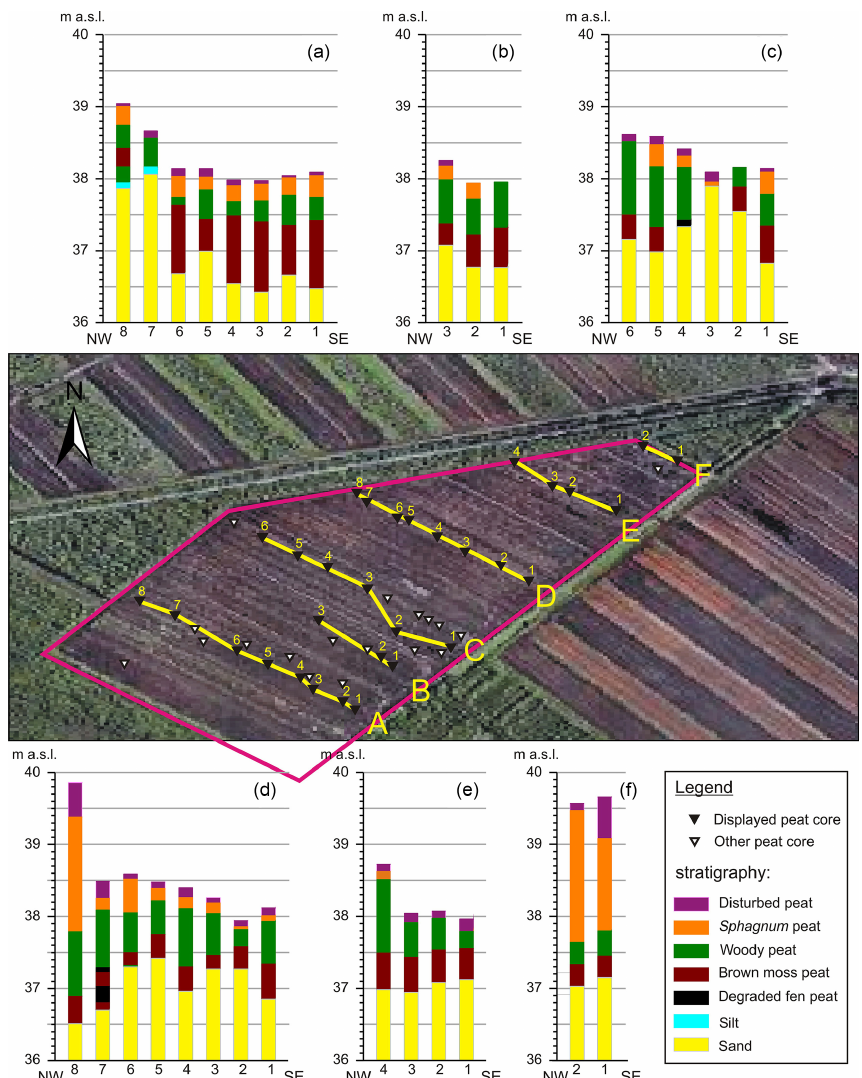
Figure 8. Peat stratigraphy. Six transects are shown with the peat stratigraphy and elevation a.s.l. of the cores. In the aerial view, site TOMO_south is outlined in pink. The locations of the displayed peat cores are indicated by black triangles, yellow lines connecting the transects. Peat stratigraphy for cores without elevation measurement is not shown. Please note that cores D8, F1 and F2 were taken at the border to the plot, where peat was left standing significantly higher than within the plot, where the tree layer was exposed.